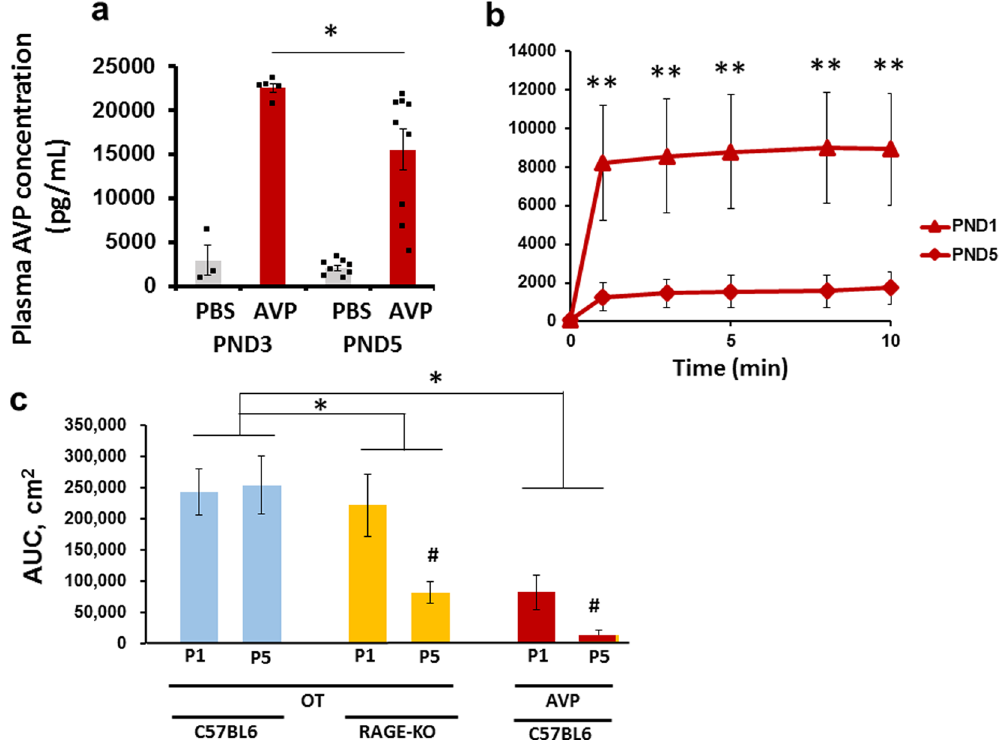
Figure 6. Plasma vasopressin concentrations in wild-type mice. ( a ) Plasma arginine vasopressin (AVP) levels in PND3 and 5 pups 10 min after oral administration of AVP (orange bars; 1 μ g of AVP/mouse) or PBS (blue bars; 10 μ L). N = 5 each. A two-way ANOVA revealed a significant difference between the two Treatments (PBS/ AVP) , F 1,18 = 5.21, P < 0.05; and for the Age effect, F 1,18 = 91.26, P < 0.0001. Bonferroni’s post hoc tests revealed P < 0.05 between AVP levels at PND3 and 5. ( b ) Time course of AVP concentrations in incubation medium (3 mL) containing a segment of the intestine isolated from PND1 (triangles) or PND5 (diamonds) wild-type pups. Five microlitres of 100 μ M AVP was injected at the proximal end after ligation. Fifteen microlitres of incubation medium was collected at the indicated time after injection. A two-way ANOVA revealed a significant difference for the Age effect F 1,40 = 25.95, P < 0.0001. Bonferroni’s post hoc tests revealed P < 0.01 between AVP levels at PND1 and 5. ( c ) The area under the curve (AUC) calculated from the plots in Figs 4a,b and 6b. Note that the AUC values of OT in wild-type pups at PND1 and PND5 and KO mice at PND1 were similar, while the AUC value of OT in PND5 KO pups was significantly lower. A two-way ANOVA showed a significant difference between the G enotypes, F 1,16 = 6.37, # P < 0.05. The AUC values of AVP in wild-type pups at PND1 = 39.92, * P < 1,16